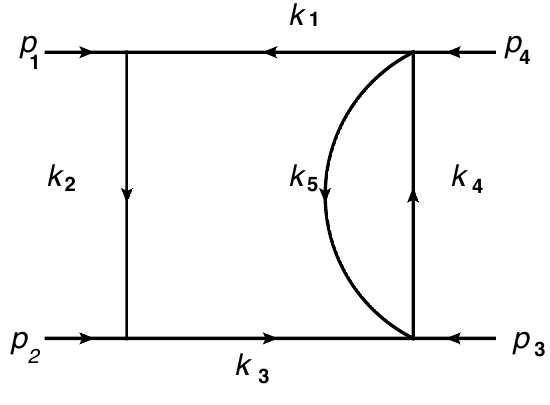
Figure 6 . The two-loop